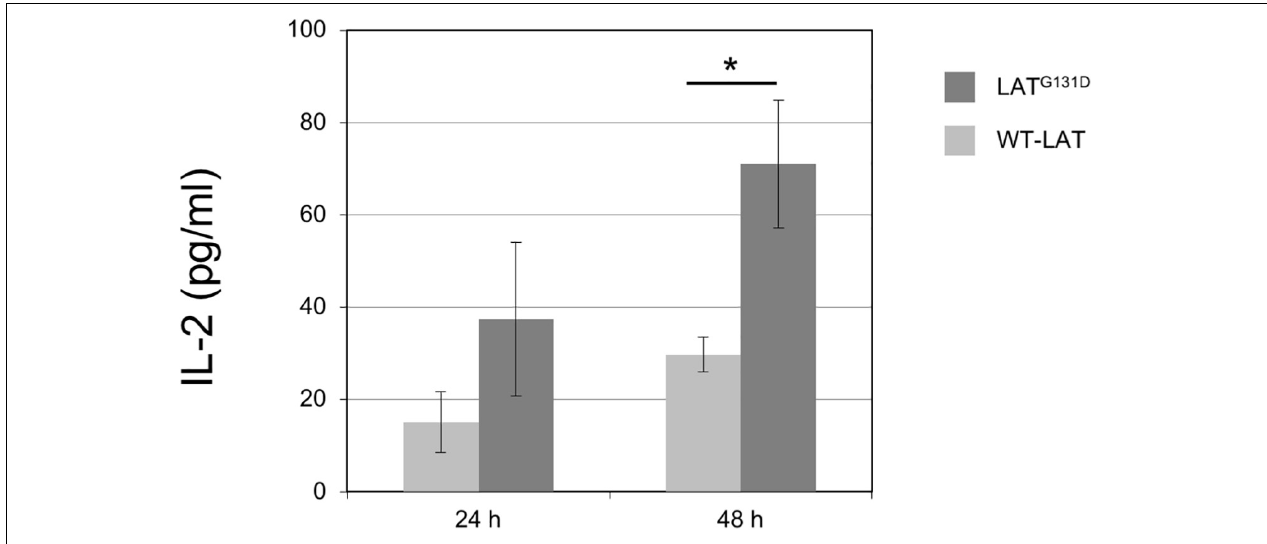
FIGURE 3 | Increased capacity of IL-2 production by J.CaM2 cells expressing the LAT G131D mutant. J.CaM2 cells expressing human WT-LAT or the LAT G131D mutant were stimulated with anti-CD3/CD28 microbeads for the indicated time in hours, and the amount of IL-2 in supernatants was measured by ELISA. The values presented are mean values of four (for 24 h incubation) or eleven (for 48 h) separate experiments. Bars represent the standard error. The asterisk represents statistical significance.